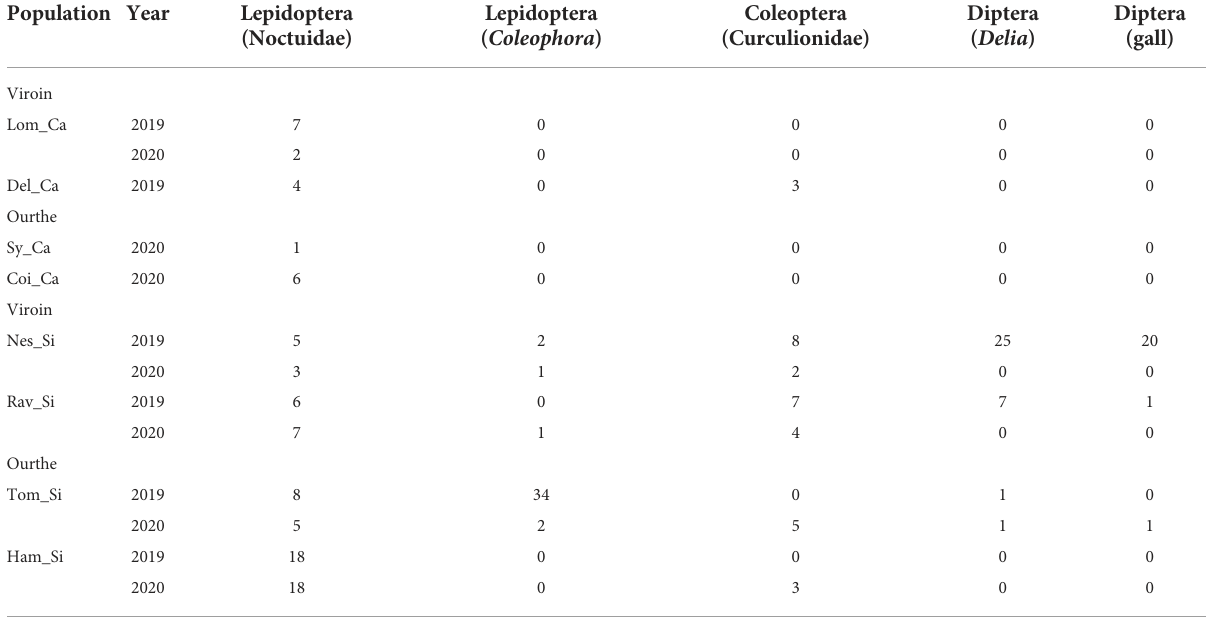
TABLE 2 List of the seed predators found on Silene nutans in eight calcicolous (_Ca) and silicicolous (_Si) populations in southern Belgium in 2019 and 2020, grouped in fi ve taxonomic